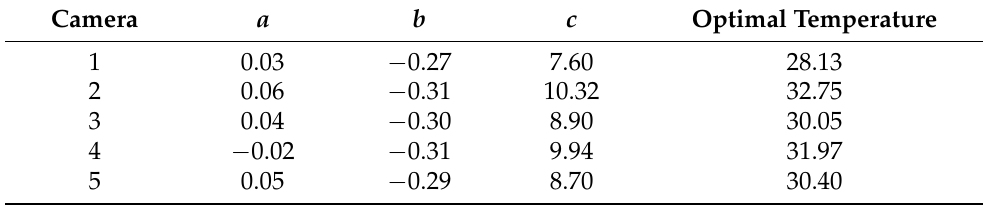
Table 1. The values of the parameters obtained with the least squares optimization.